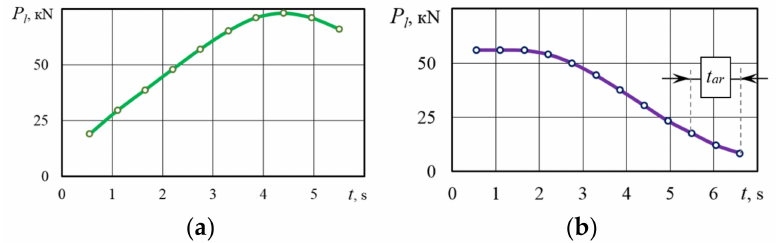
Figure 8. Change in lateral force on the rotor during the half-cycle: ( a ) 1 − V s = 104 m/h, V c = 6 m/s, t ar = 0 s; 2 − V s = 104 m/h, V c = 9 m/s, t ar = 0 s; ( b ) V s = 104 m/h, V c = 6 m/s, t ar = 1.1